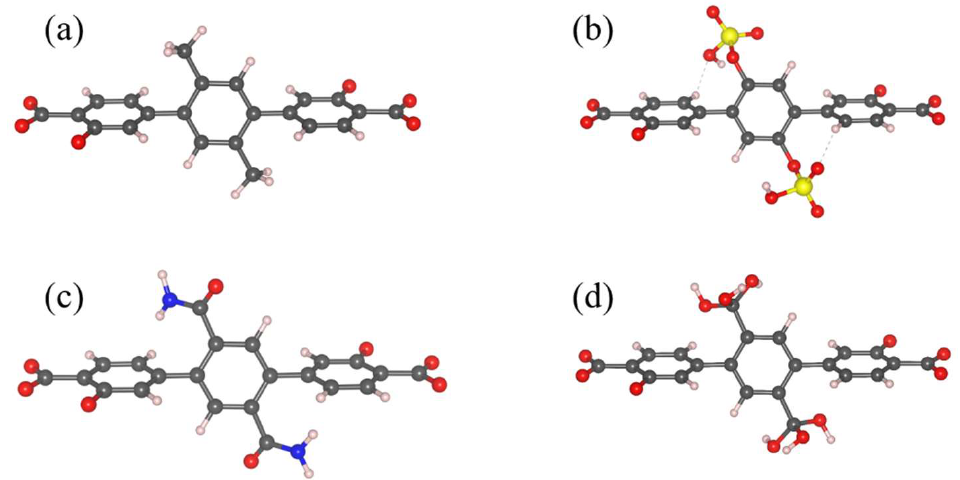
Figure 3. The functionalized linker structure of Mg-MOF-74-III considered in the GCMC simulations; the original Mg-MOF-74-III linker ( a ), the –OSO 3 H ( b ), –CONH 2 ( c ) and –C(OH) 3 ( d ) functionalized linker. Carbon, hydrogen, oxygen, sulfur and nitrogen atoms are depicted as grey, pink, red, yellow and blue spheres, respectively.